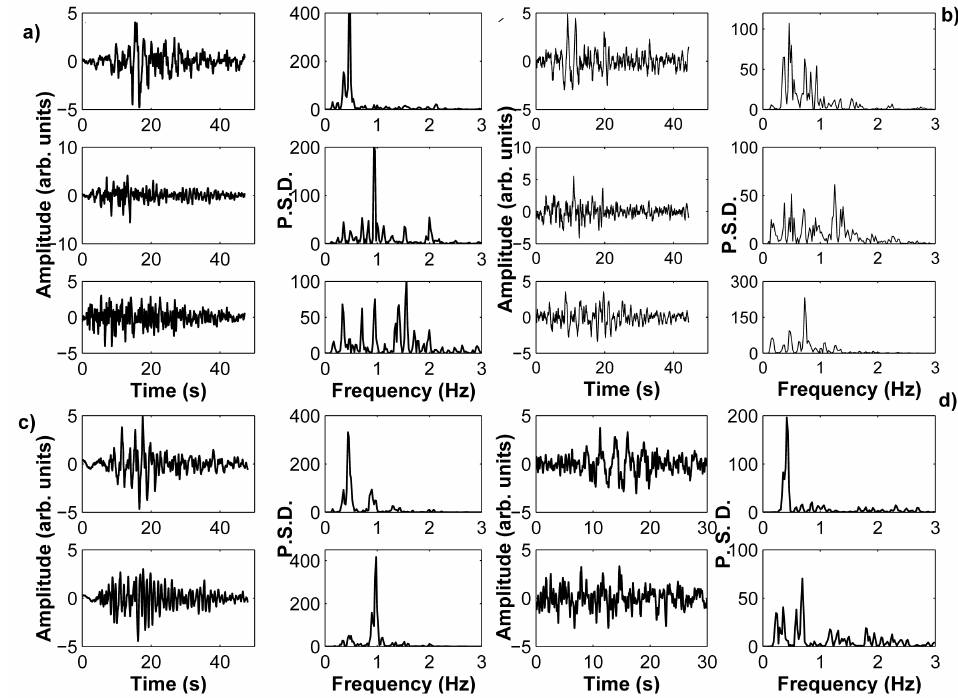
Fig. 13. Independent components of Colima LP events in time and frequency domain at the four stations (COCA (a) , COBA (b) , COME (c) , COTE (d) ). Figure extracted from De Lauro et al.